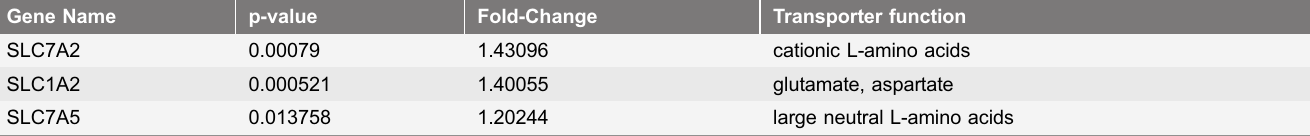
Table 2. Amino acid transporters up-regulated in hMDMs infected by L. pneumophila